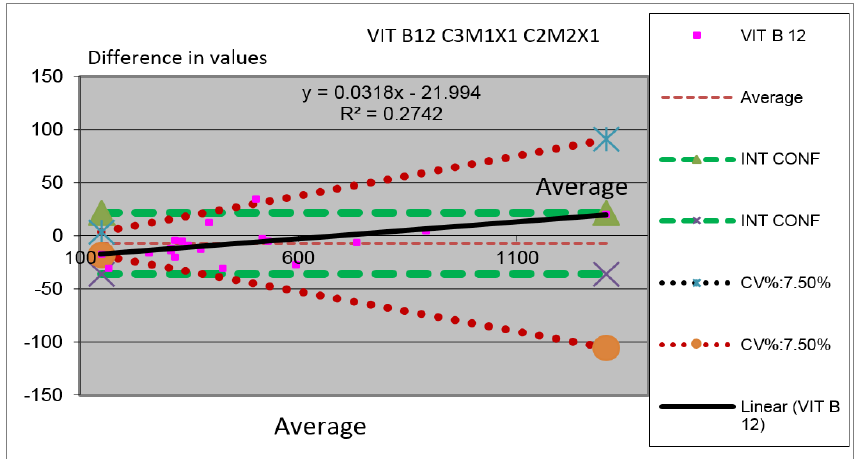
Figure 7. Comparison between modules for the Vitamin B12 parameter in which we have compared the results obtained by the measurements performed in the two machines (Analyzer C3 substituted by C2 in which the Module 1 is substituted by the Module M2 and the Channel X1 is substituted by the Channel